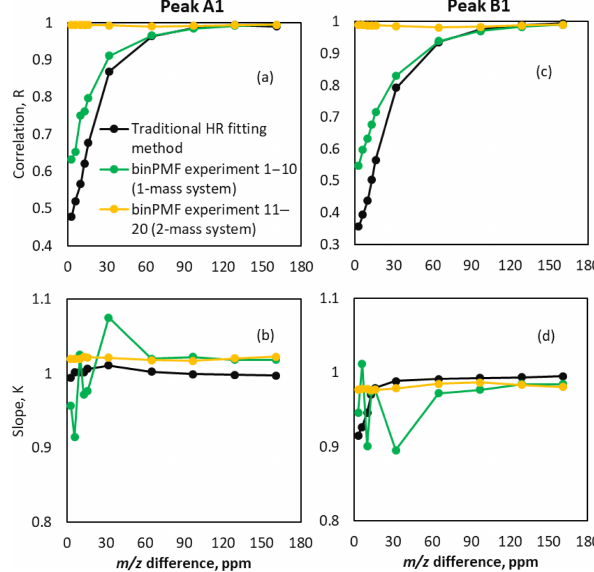
Figure 6. Comparison of time series of binPMF and HR fitting. Pan- els (a) and (b) show results for peak A1 and (c) and (d) for peak B1. Correlation of time series (a, c) retrieved by binPMF (green lines for experiments 1–10, yellow for 11–20) and traditional HR fitting (black lines) compared to original input data. Panels (b) and (d) depict the slope K of the linear fit y = k × x , where y is the signal retrieved from the synthetic data by either binPMF or the HR fitting, and x is the original input